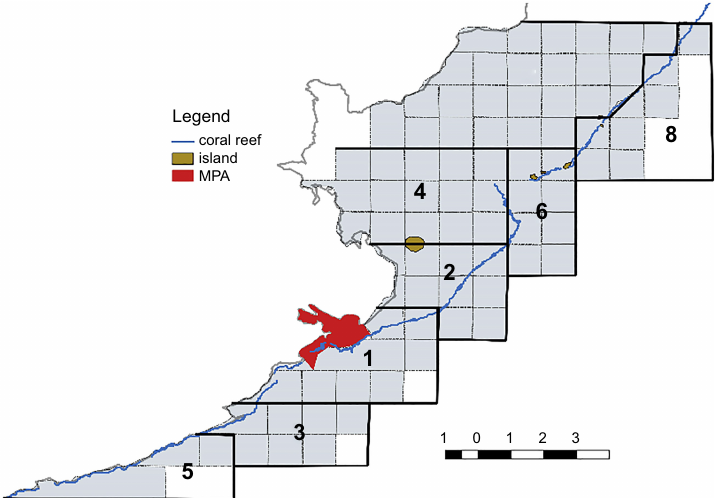
Figure 1. Fishing location